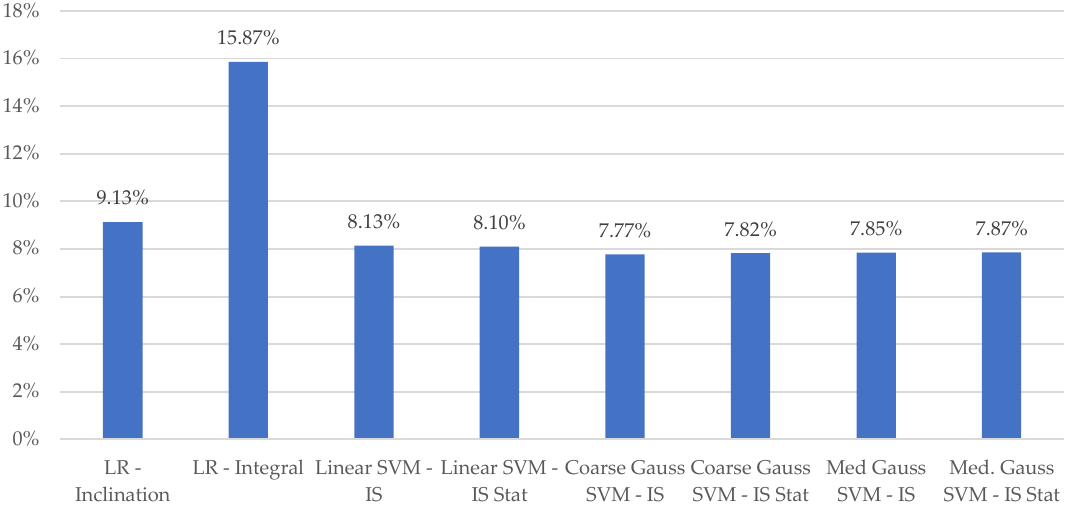
Figure 9. Distribution of volume mean overall absolute percentage error after 12 drinks for the best- case estimator.